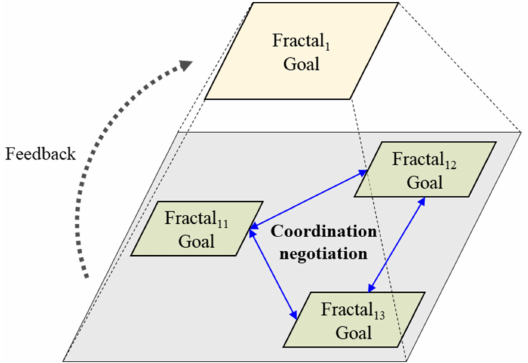
Figure 5. The goal-formation process by Ryu et al. (modified from